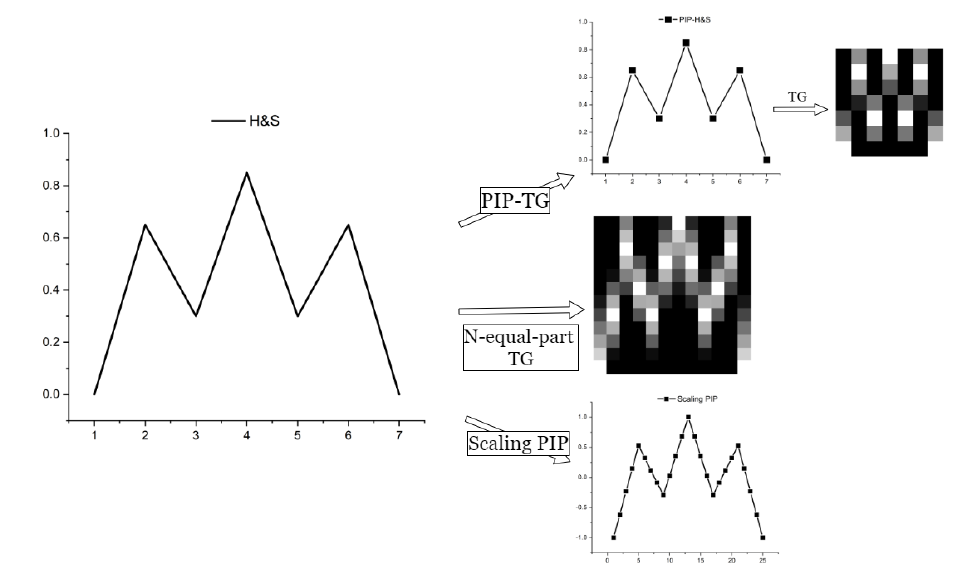
Figure 6. Three different representations. The value of the TG cell ranging from [ − 1,1 ] is shown as the gray-level image for visualization. There would be only one cell value that was equal to 1 in each column. Here, the dimension of the grid is 12. The scaling PIP is generated by the scaling procedure and it will be described in detail in Section 4.